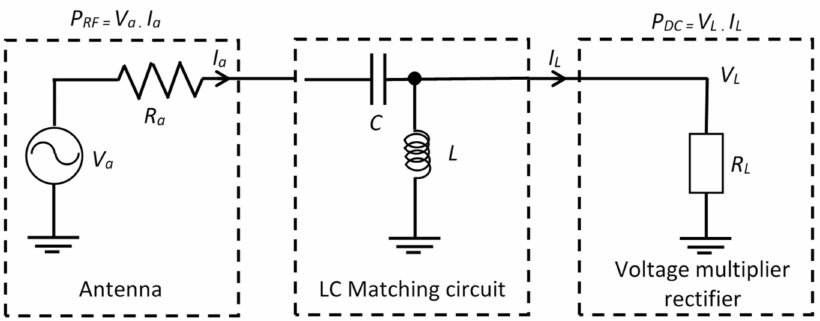
Figure 1. Schematic diagram of receiving